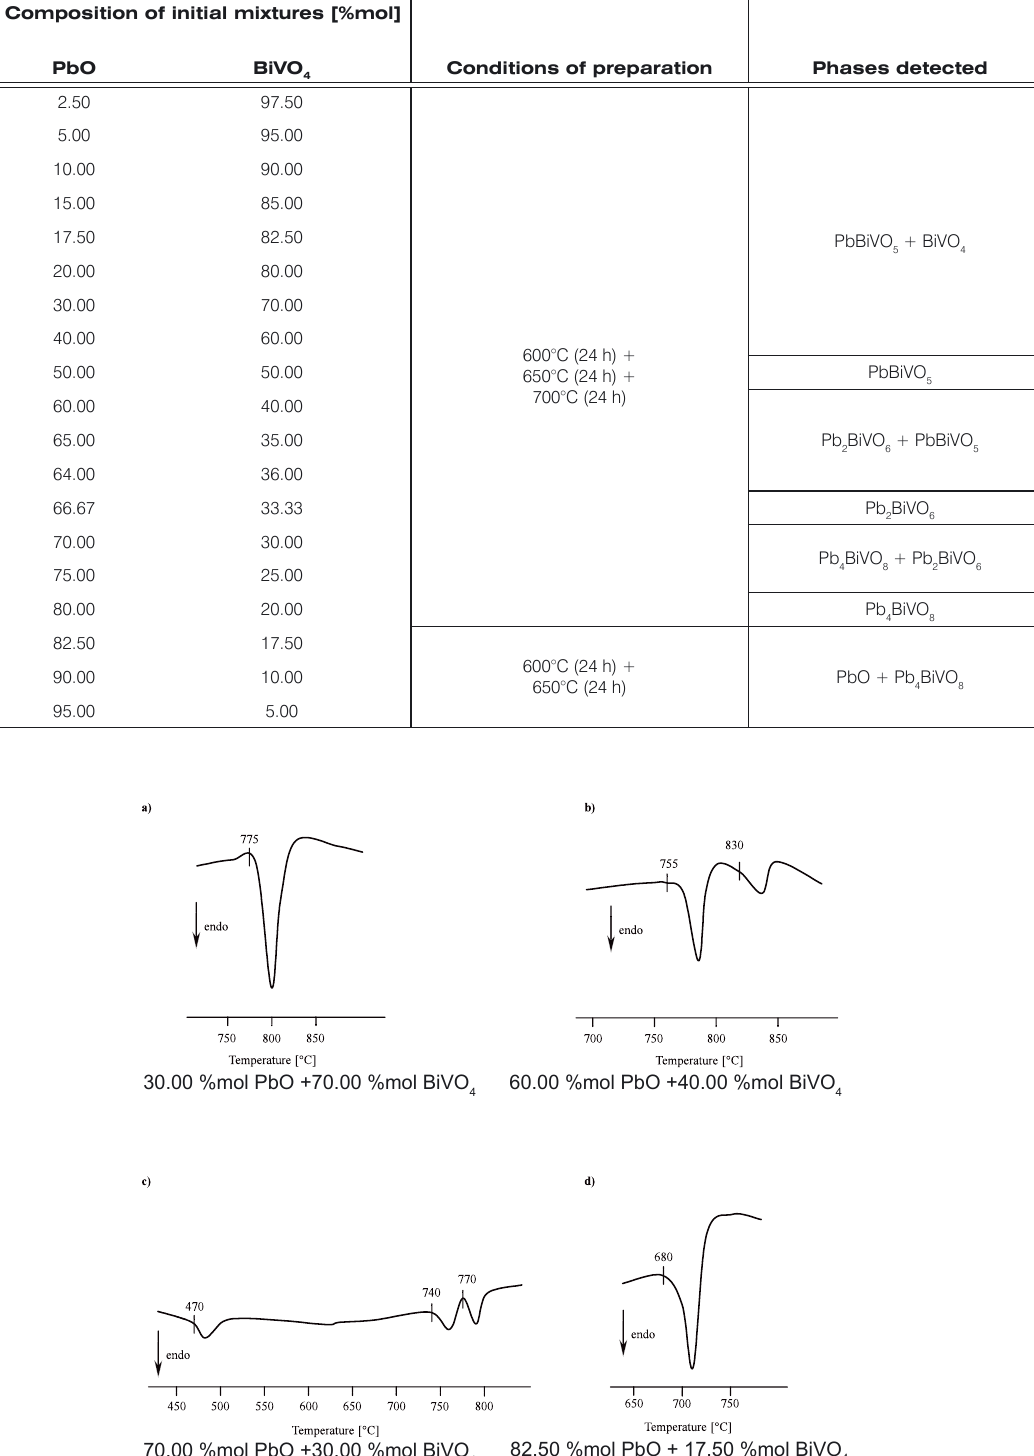
Figure 3. DTA curves of selected samples of the investigated system.